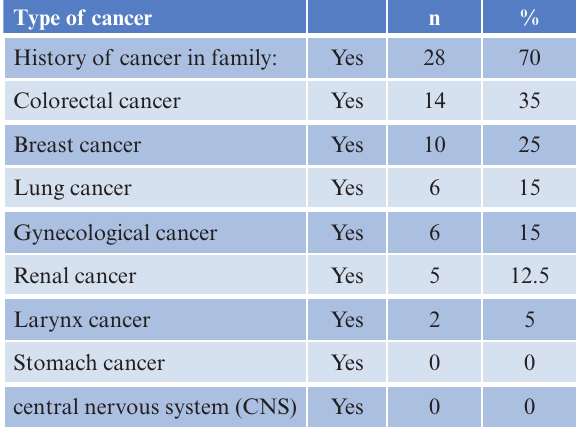
Table 3. The presence of cancer in family